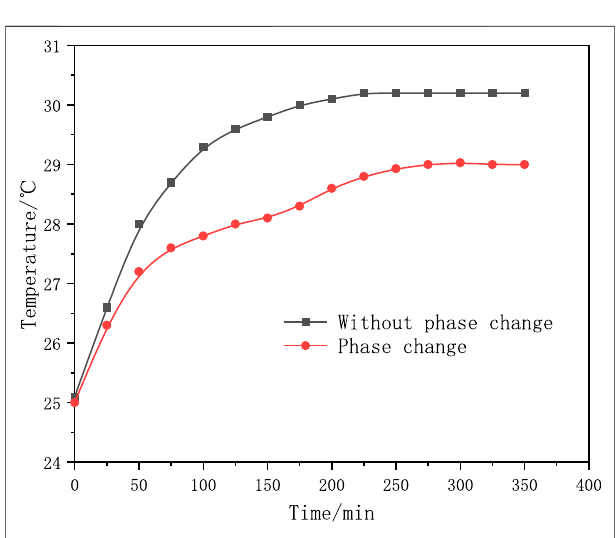
FIGURE 16 | Temperature change curves of fl oor of the building model with and without phase